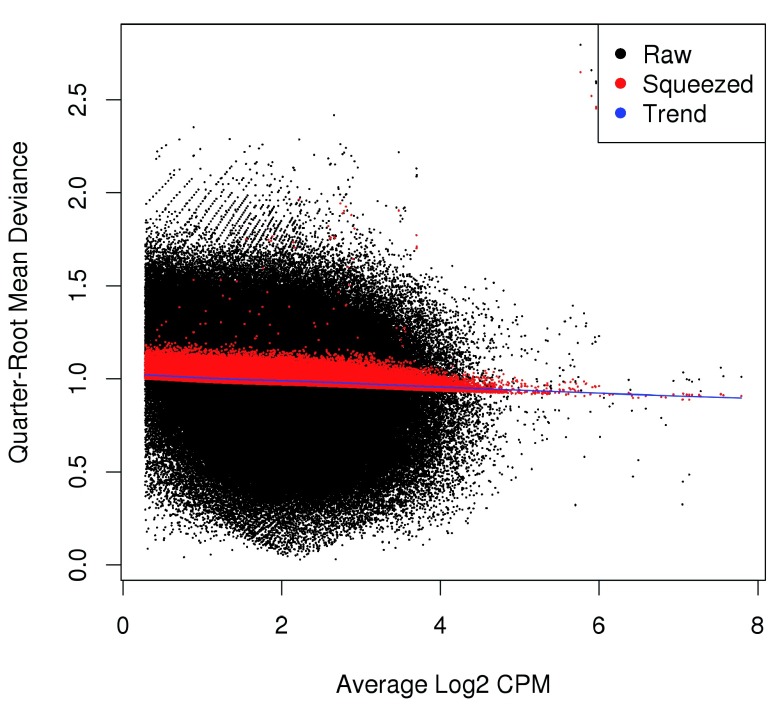
Effect of EB shrinkage on the raw QL dispersion estimate for each window (black) towards the abundance-dependent trend (blue) to obtain squeezed estimates (red).